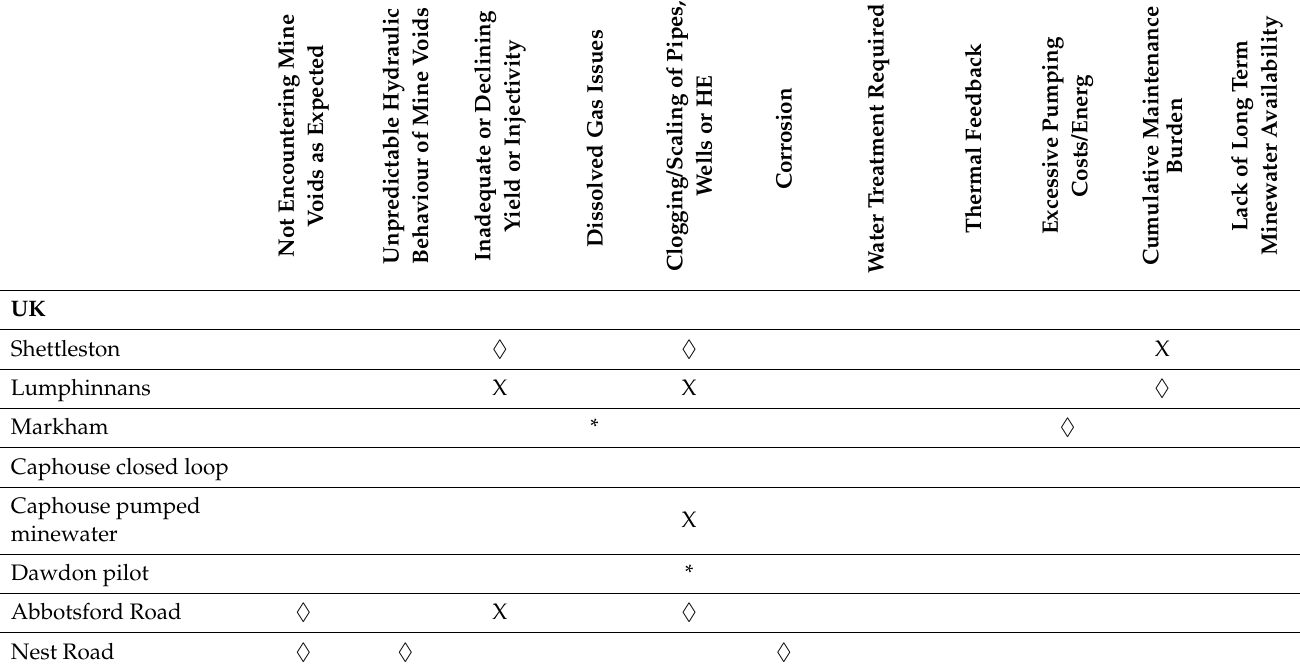
Table 2. (Overleaf) Issues reportedly encountered at the described MWG schemes. X = major difficulty, ♦ = some difficulty, * potential difficulty, but resolved. Grey cells = no information. HEX = heat exchanger. Be aware that there is a correlation between difficulties reported and detail of